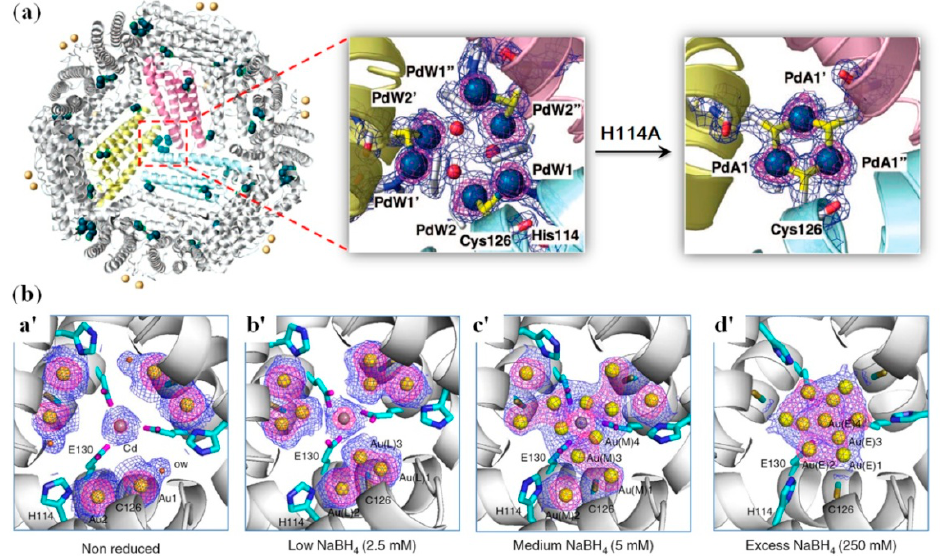
Figure 4. ( a ) Pd(allyl) complexes binding to the threefold channel of apo-Fr, which form a trinuclear Pd-cluster as a result of H114A mutation. Reprinted with permission from Ref. [76], Copyright 2008 American Chemical Society. ( b ) X-ray crystal structures Au-loaded apo-Frs in the absence and presence of different concentrations of NaBH 4 , showing the process of formation of an Au-cluster at the threefold channel of apo-Fr[77].